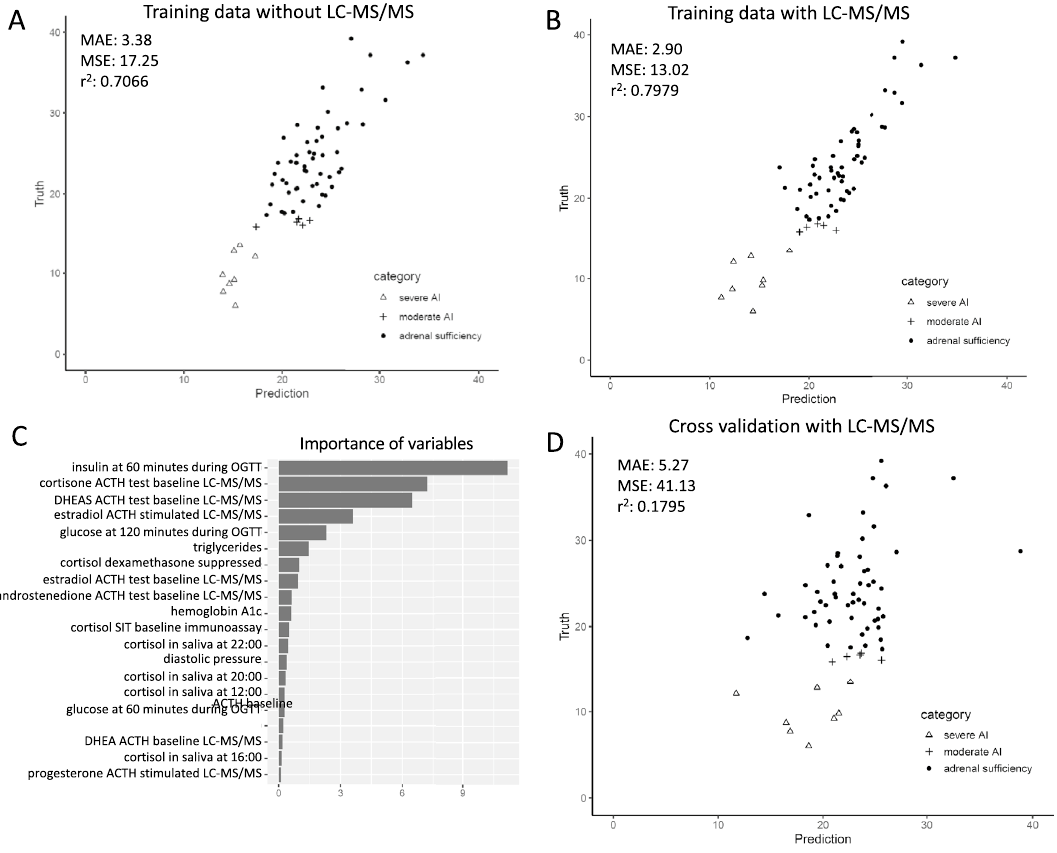
Figure 4. Plot of the true value and predicted value by model-based-boosting model without ( A ) and with ( B ) LC–MS/MS in training data. Importance of variables in model-based-boosting model ( C ). Plot of the true value and predicted value by model-based-boosting model with LC–MS/MS in cross validation ( D